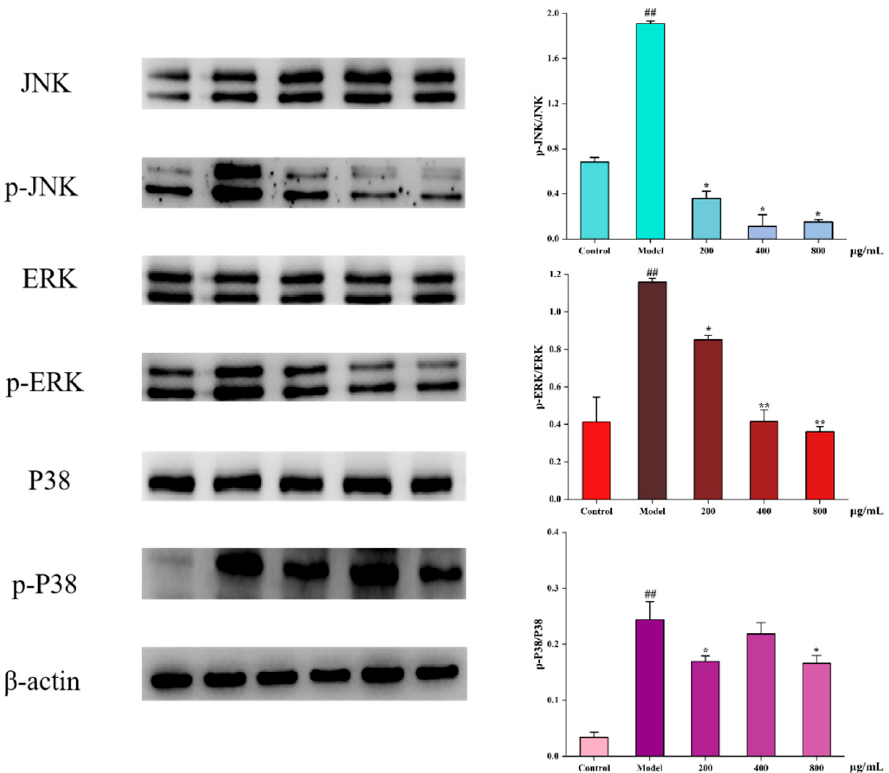
Figure 5. Effects of CYP on the H 2 O 2 induced MAPK pathway of IEC-6 cells. Results shown are expressed as means ± SD (n = 3). ## p < 0.01 compared with normal group, * p < 0.05 compared with H 2 O 2 group alone, ** p < 0.01 compared with H 2 O 2 group alone.